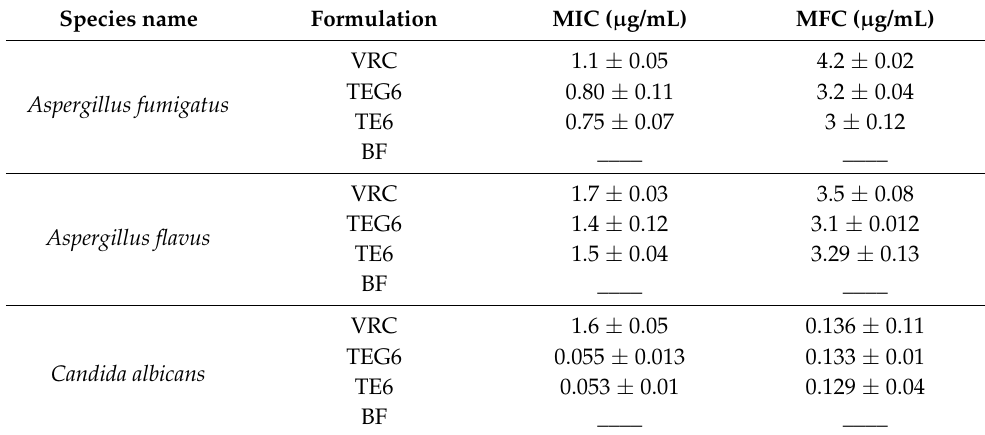
Table 5. Antifungal activity MIC and MFC value in µg/mL (Mean ± SD, n = 5).